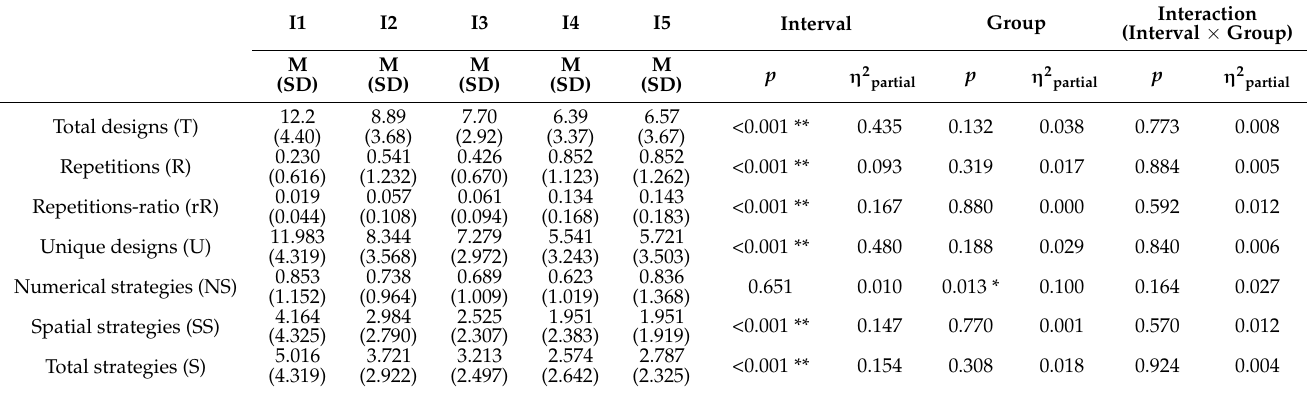
Table 4. Results of the Repeated-Measures Analysis of Variances.